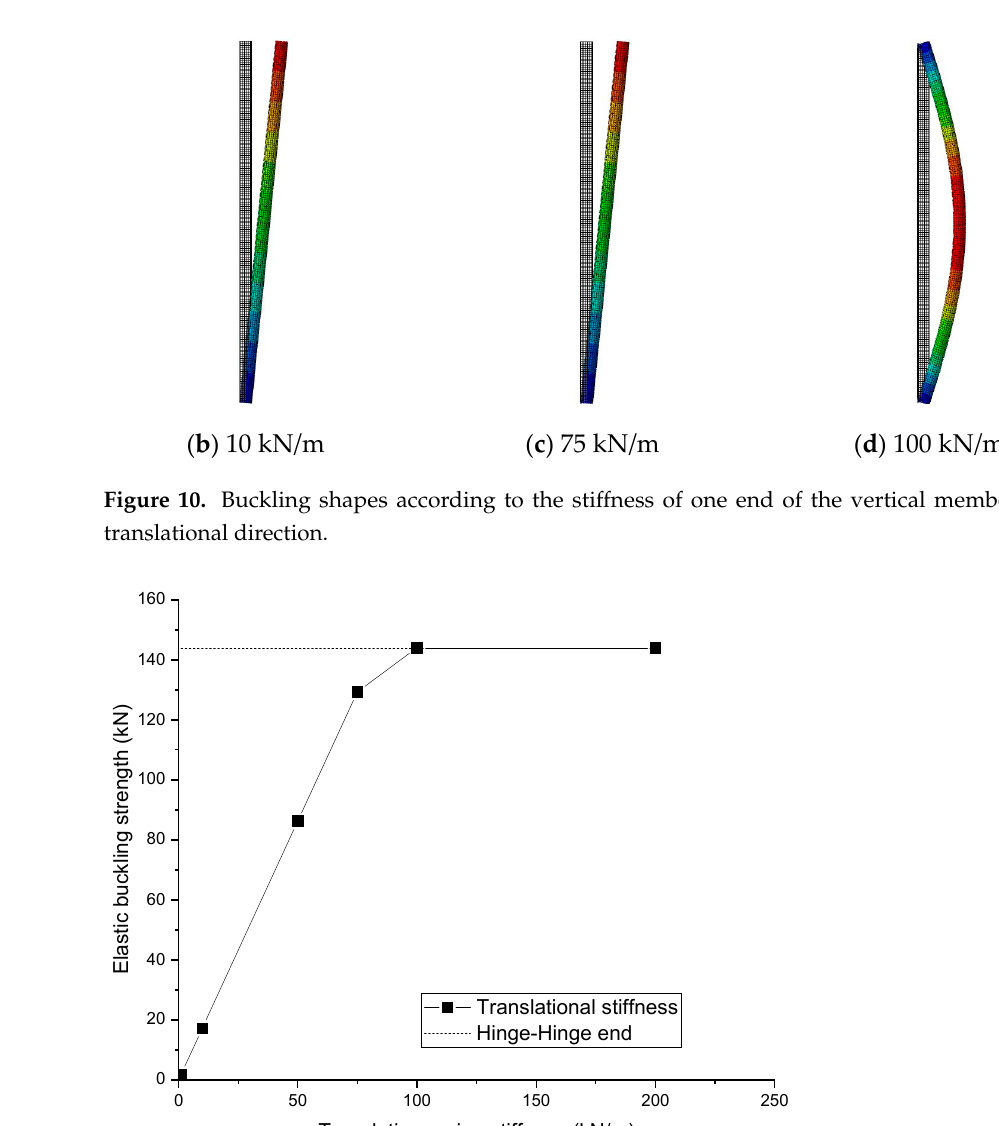
Figure 9. Buckling strength curve according to rotational stiffness.